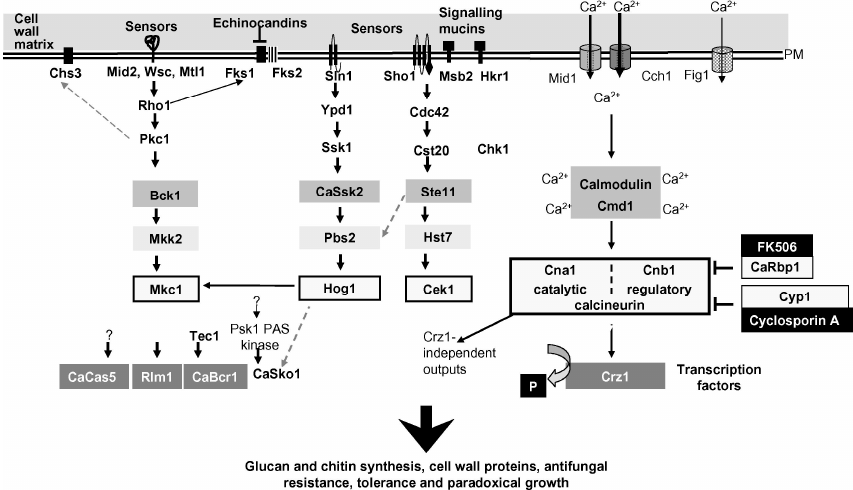
Figure 8. Diagram of input signal and signaling pathways activated in C. albicans by cell wall stress. Reproduced from [92]. On the right (in the black box), the inhibitors of calcineurin and in white the target proteins. P in the black box represents the phosphate group that calcineurin removes from Crz1p. The question mark on Psk1p indicates that cell wall damage activates Psk1p in an unknown manner. The question mark on CaCas5 indicates an unknown activator of this TF that regulates the cell wall stress-response.